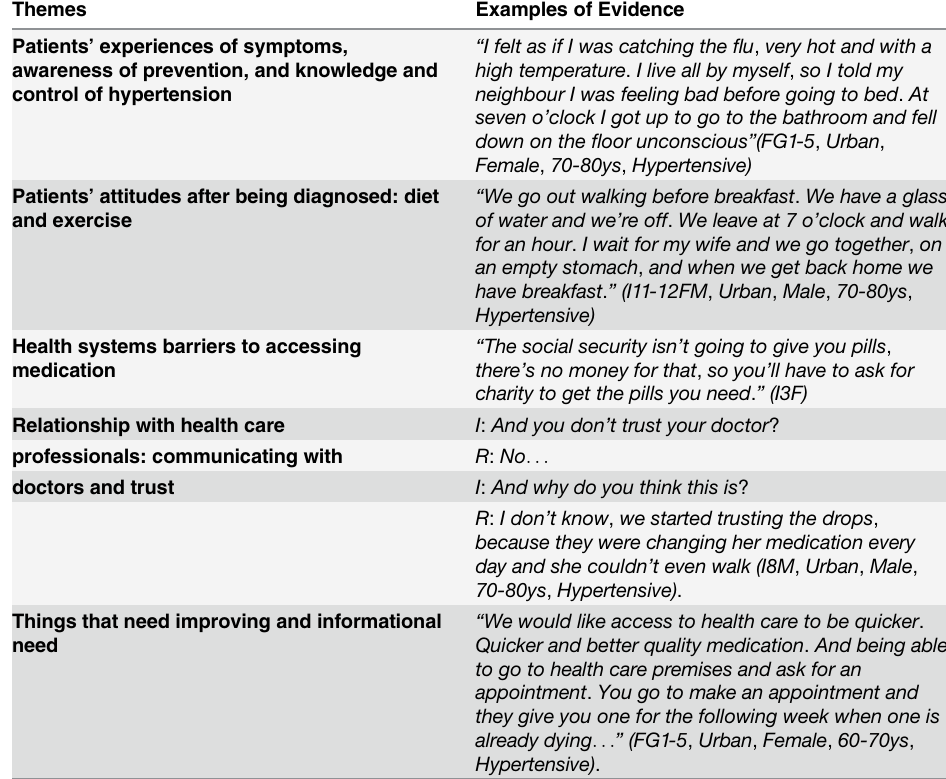
Table 3. Key Themes and examples of the